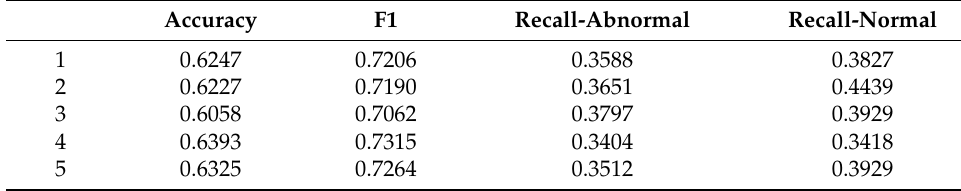
Table 4. Results for sampling ratios = 1:2 with k =